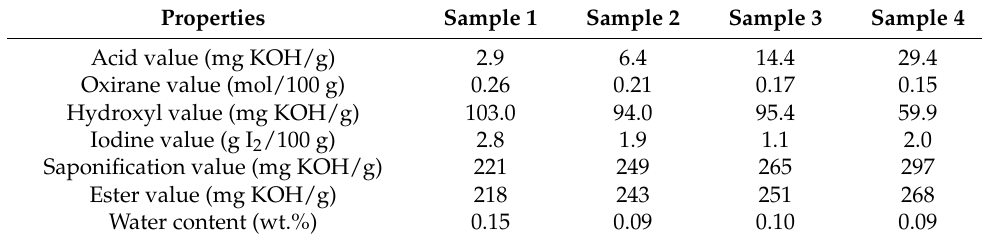
Table 5. Chemical properties of epoxidized mixed esters (Samples